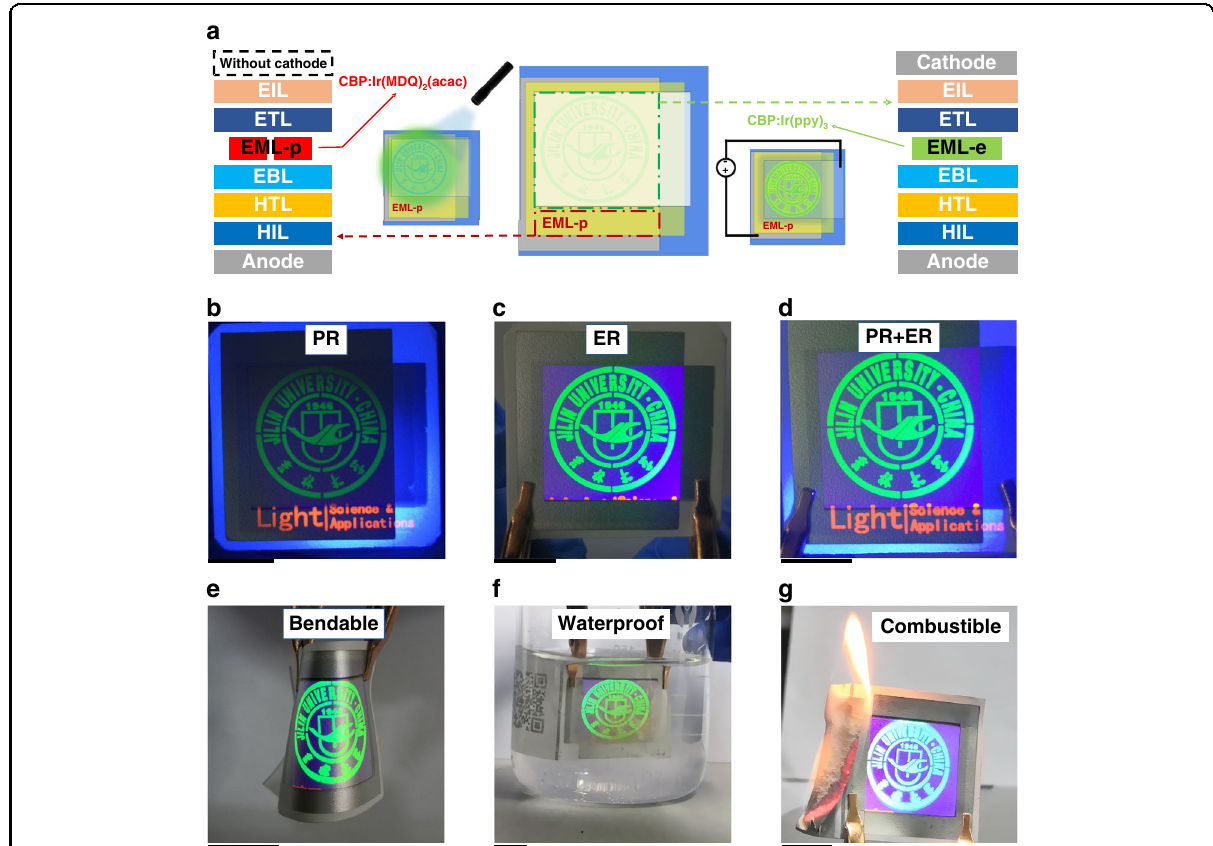
Fig. 4 Anticounterfeiting device with multiple stimuli responsiveness. a Schematic diagrams of the working mechanism of the proposed fl exible anticounterfeiting device. b Photoresponse (PR) of the FAC device under 365 nm light stimuli, c electro-response (ER) of the FAC device under 5 V, d PR and ER of the FAC device under light and electricity stimuli. Images of the FAC device in response to electricity stimuli, e after being bended, f after being put into deionized water, and g after being set on fi re. Black scale bar of each fi gure represents the length of 1